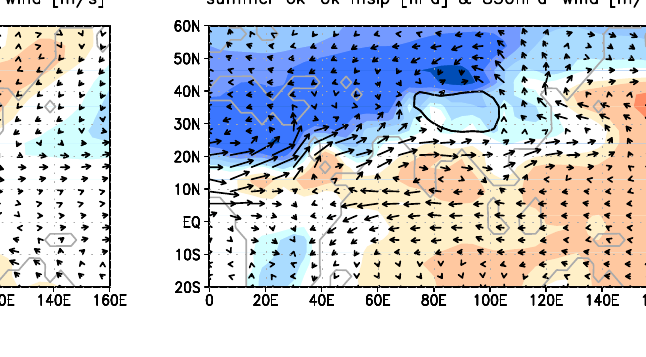
INCPIN ( − 0.4mm/day) and YANG ( − 0.33mm/day).